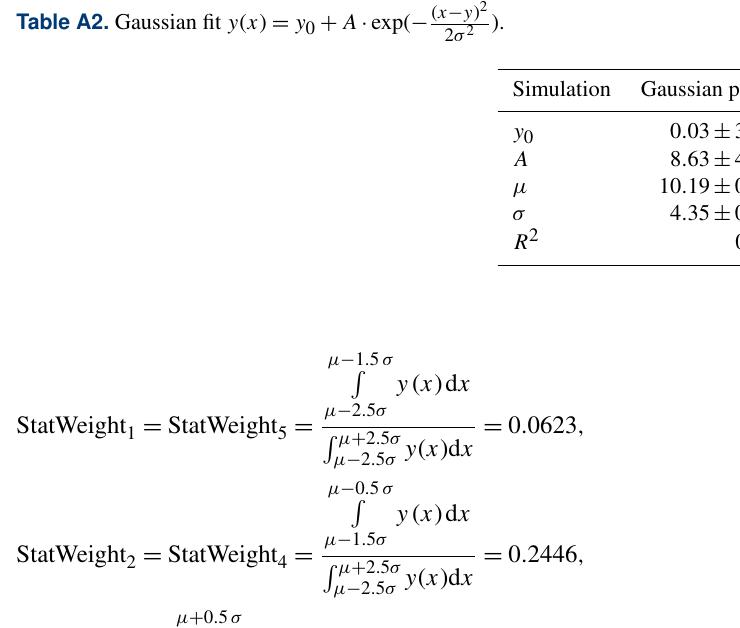
Table A2. Gaussian fit y ( x ) = y 0 + A · exp( − ( x